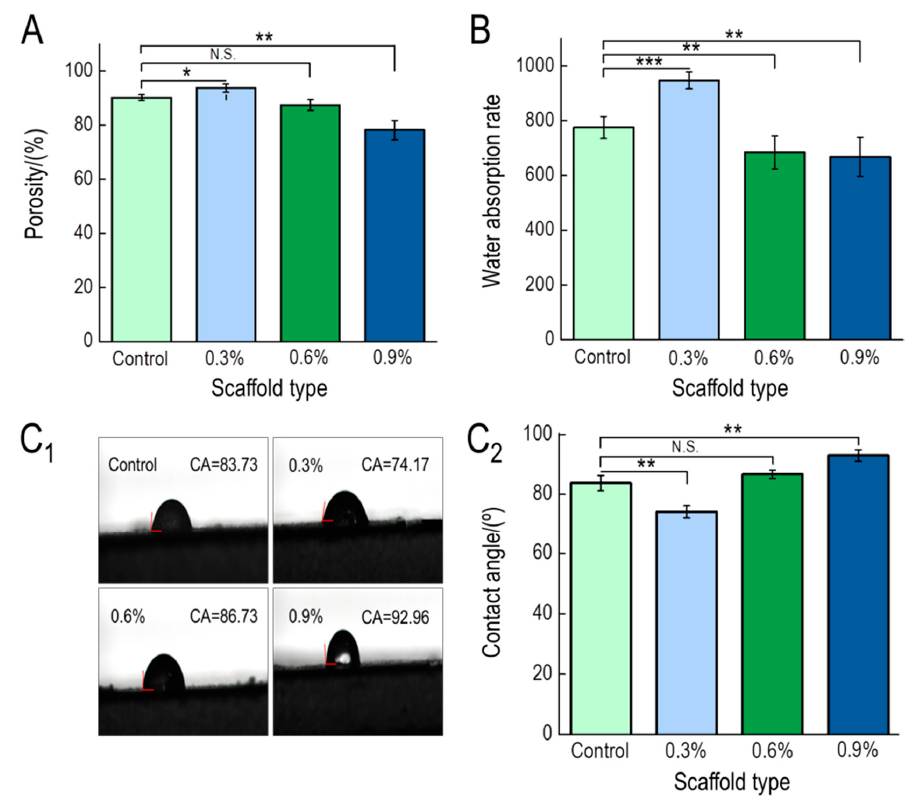
Figure 4. ( A ): Porosity of CS/Gel/nHAp/MWCNTs scaffolds. CS/Gel/nHAp/0.3%MWCNTs scaffold had the greatest porosity. ( B ): Water absorption rate of CS/Gel/nHAp/MWCNTs scaffolds. The CS/Gel/nHAp/0.3%MWCNTs scaffold had the highest water absorption rate. ( C 1 , C 2 ): Contact angle of CS/Gel/nHAp/MWCNTs scaffolds. CS/Gel/nHAp/0.3%MWCNTs had the smallest contact angle, indicating that it was the most hydrophilic scaffold. Data indicate mean ± SD. N.S: p > 0.05, * p < 0.05, ** p < 0.01, *** p < 0.001.